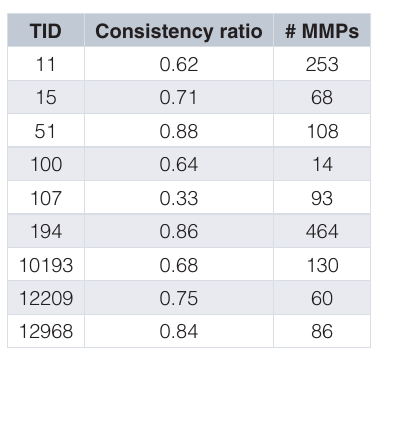
Table 5. MMP-based analog search of the top 30 compounds. The consistency ratio and number of MMPs for the top 30 compounds based on the distance to the optimized coordinates are